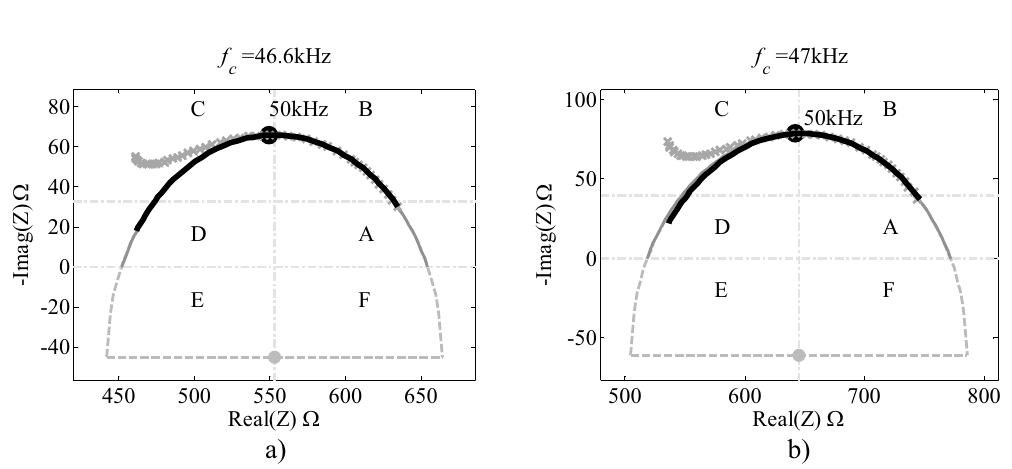
Figure 2. Complex representation (Nyquist plot) of the best ( a ) and the worst ( b ) fittings obtained from subset 0. The three models shown for each spectrum correspond to the data in Table 3. The black, thicker line corresponds to the 3P model (it covers the frequencies of the spectra), the solid thinner line corresponds to NLS method (going from R 0 to R ∞ ) and the dashed line corresponds to the 3P-NLS method (it covers the whole semicircle). The shape of both spectra look similar, but their values are not. The modelling with the 3P method gives a curve with a slight inward